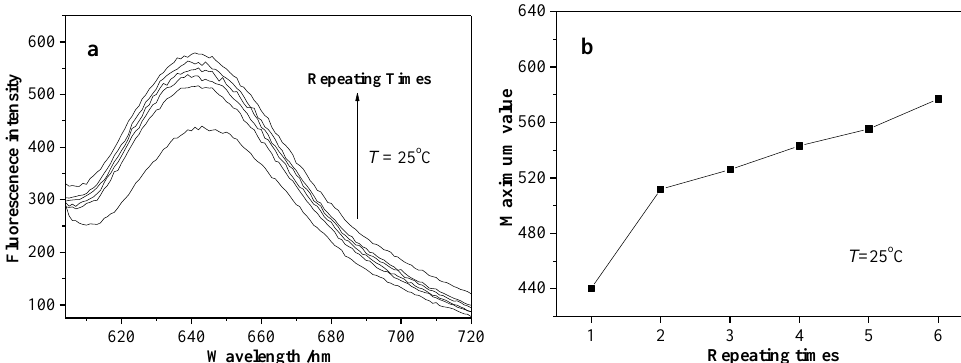
Figure 13. Fluorescence spectra ( a ) and maximum value (( b ), at 645 nm) of NR-S3 micellar solution at 25 °C through the repeated heating and cooling processes for four times.